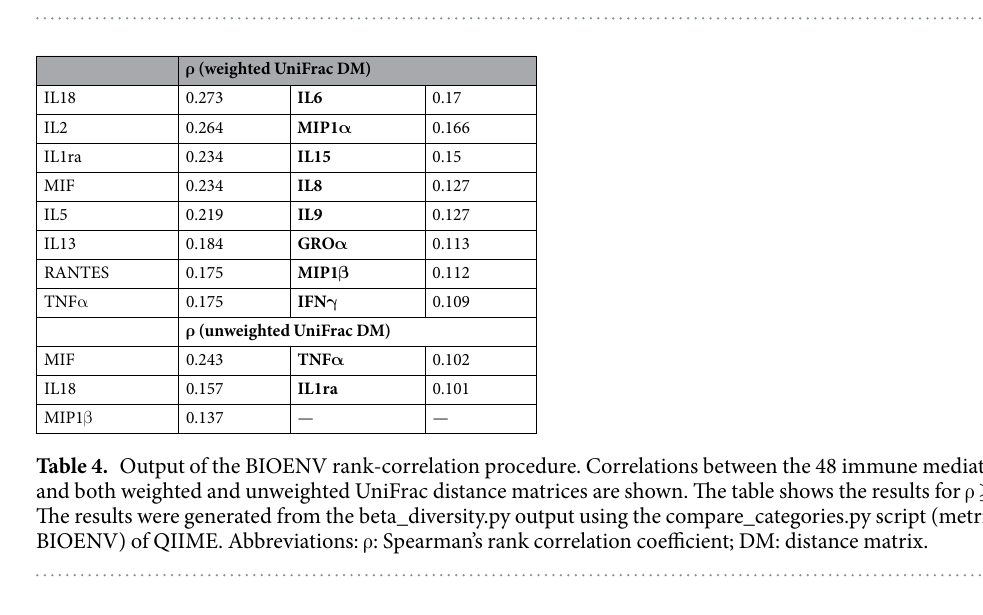
Table 3. Significant variations in soluble immune factors. Data are shown as the mean value (pg/ mL) ± standard error of mean. Comparisons between groups were performed using a non-parametric Kruskal- Wallis test. The p values are adjusted for multiple comparisons. Significant p values are highlighted in bold.